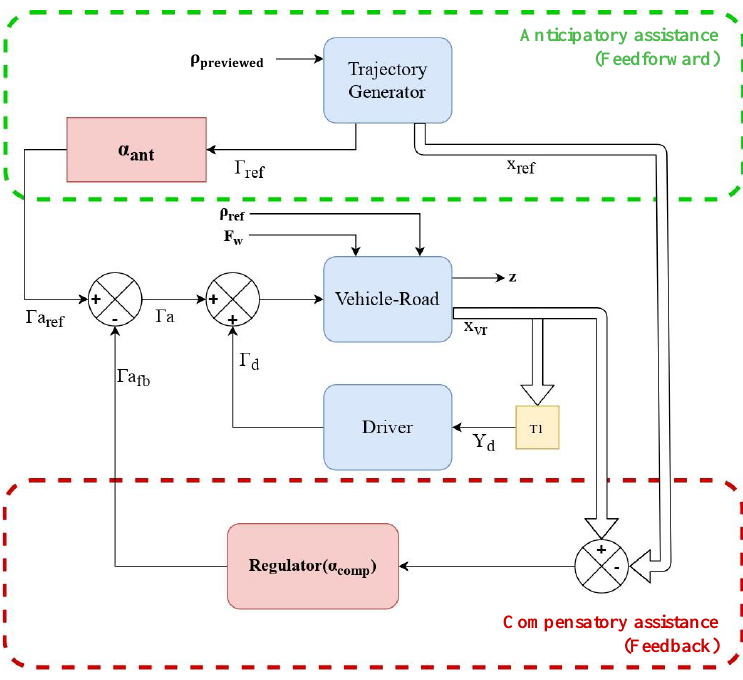
Figure 2. Design strategy of Haptic Guidance